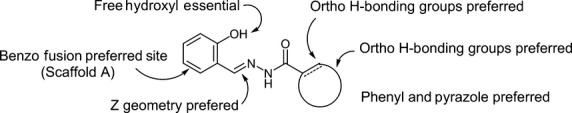
Summary of SAR analysis.